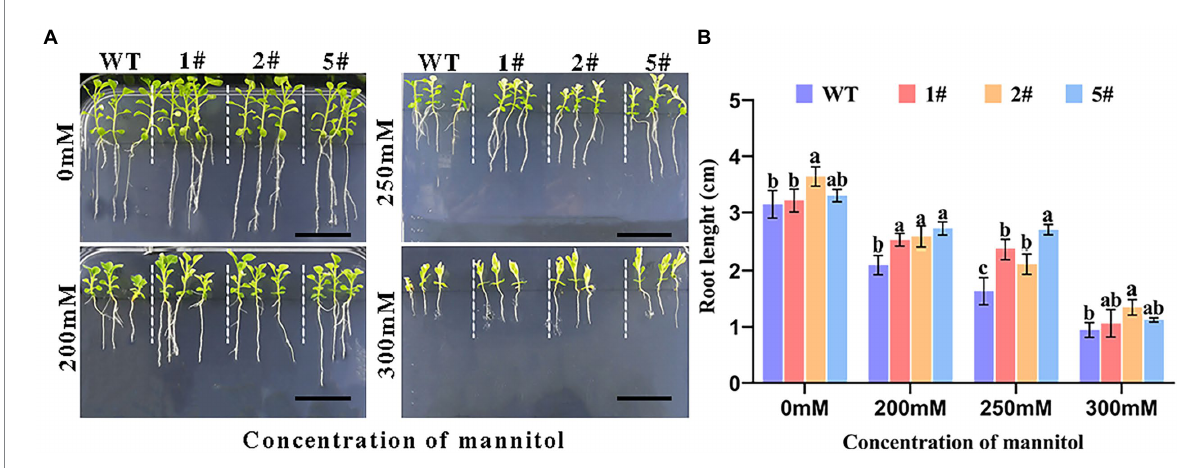
FIGURE 6 Plant root growth of strain overexpressing AfNAC1 and wild-type plants under different concentrations of mannitol stress treatment. WT: wild-type plants; #1, #2, and #5 are three different strains of overexpressing plants. (A) Plant root elongation phenotype. (B) Plant root measurement data. Error lines indicate the standard errors of three biological replicates with significant differences at the p < 0.05 level. Bar, 20 mm.